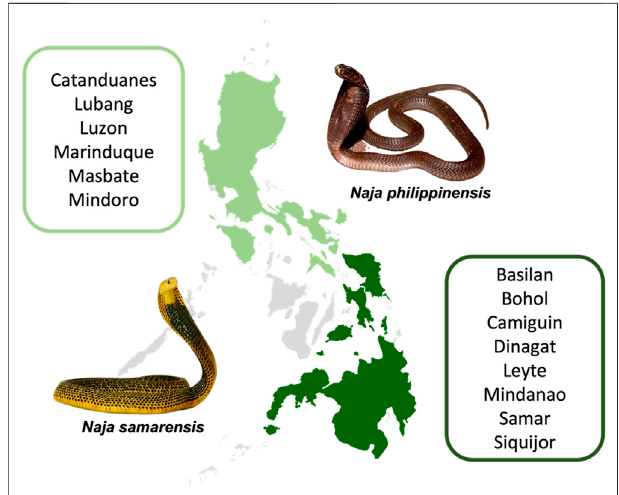
FIGURE 1 | Geographical distribution of the Northern Philippine Cobra ( Naja philippinensis ) and Samar Cobra or Southern Philippine Cobra ( Naja samarensis ). Regions shaded in green are where the cobras are native to: N. philippinensis (light green); N. samarensis (dark green). Words in green boxes next to the shaded areas refer to islands in the Philippines where the respective cobra species can be found (Sy and Mangkabong, 2018; Sy and Bucol, 2020; Uetz et al., 2021a; Uetz et al.,